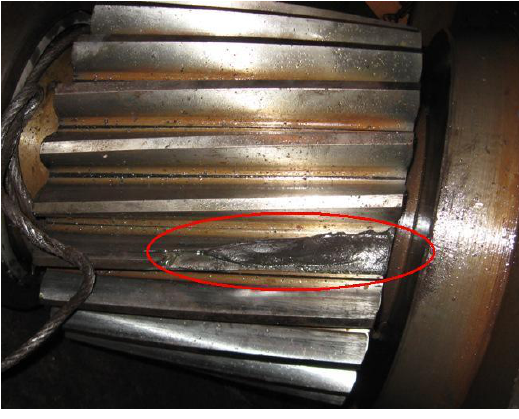
Figure 12. The real case of broken cog fault of Z5 (25-tooth) helical gear.